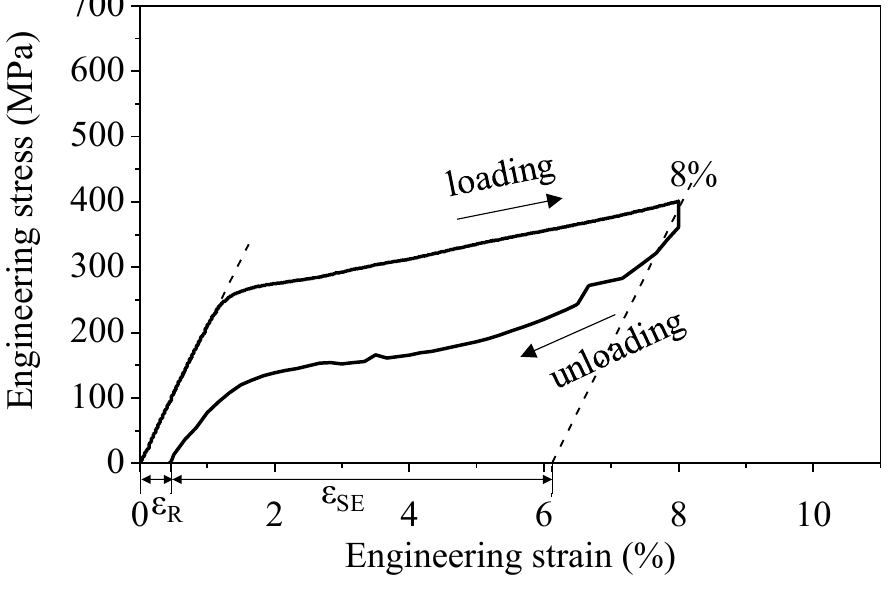
Figure 1. Stress-strain curve of a Cu-Al-Mn tensile